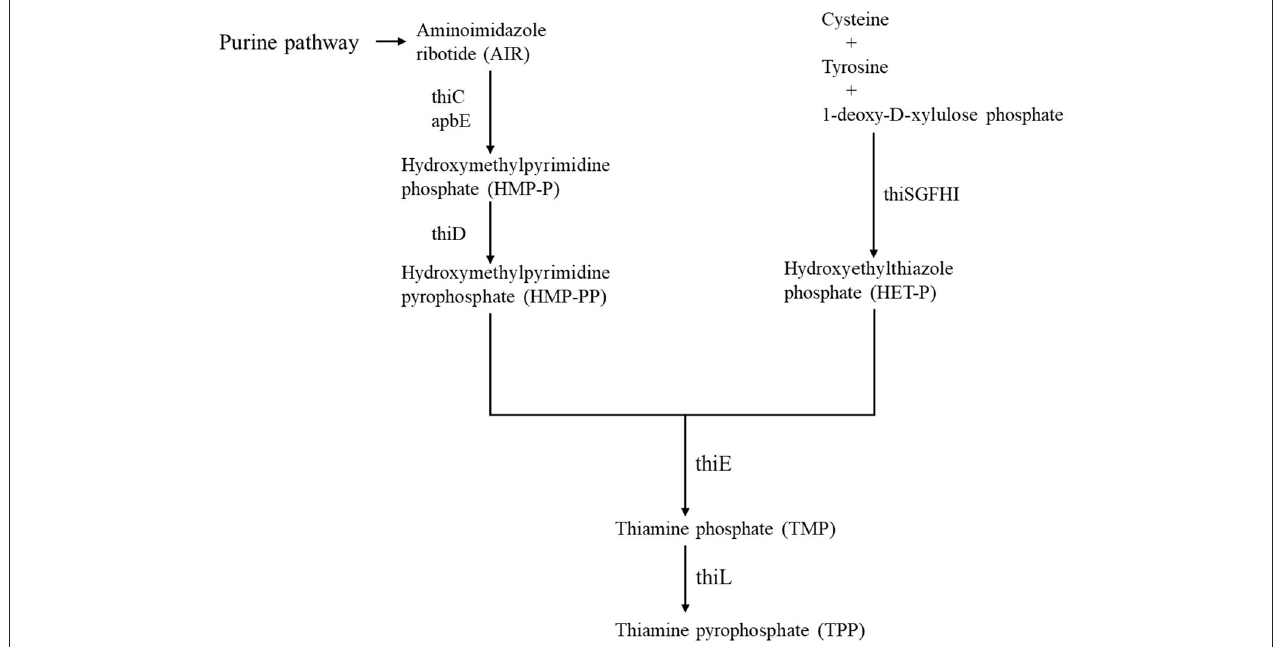
FIGURE 1 | Diagram showing a putative thiamine biosynthesis pathway. Black arrows indicate thiamine biosynthetic (TBS) pathway. HMP-P, hydroxymethyl pyrimidine phosphate; HMP-PP, 4-amino-5-hydroxymethyl-2-methylpyrimidine diphosphate; HET-P, 5-(2-hydroxyethyl)-4-methylthiazole phosphate; TMP, thiamine monophosphate; AIR, aminoimidazole ribotide; TPP, thiamine